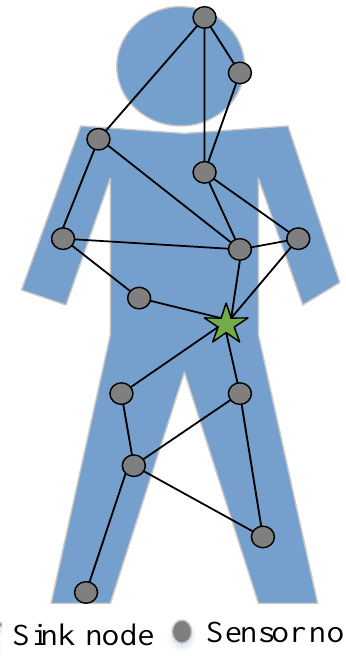
Figure 2. Logical topology of wireless body area network.